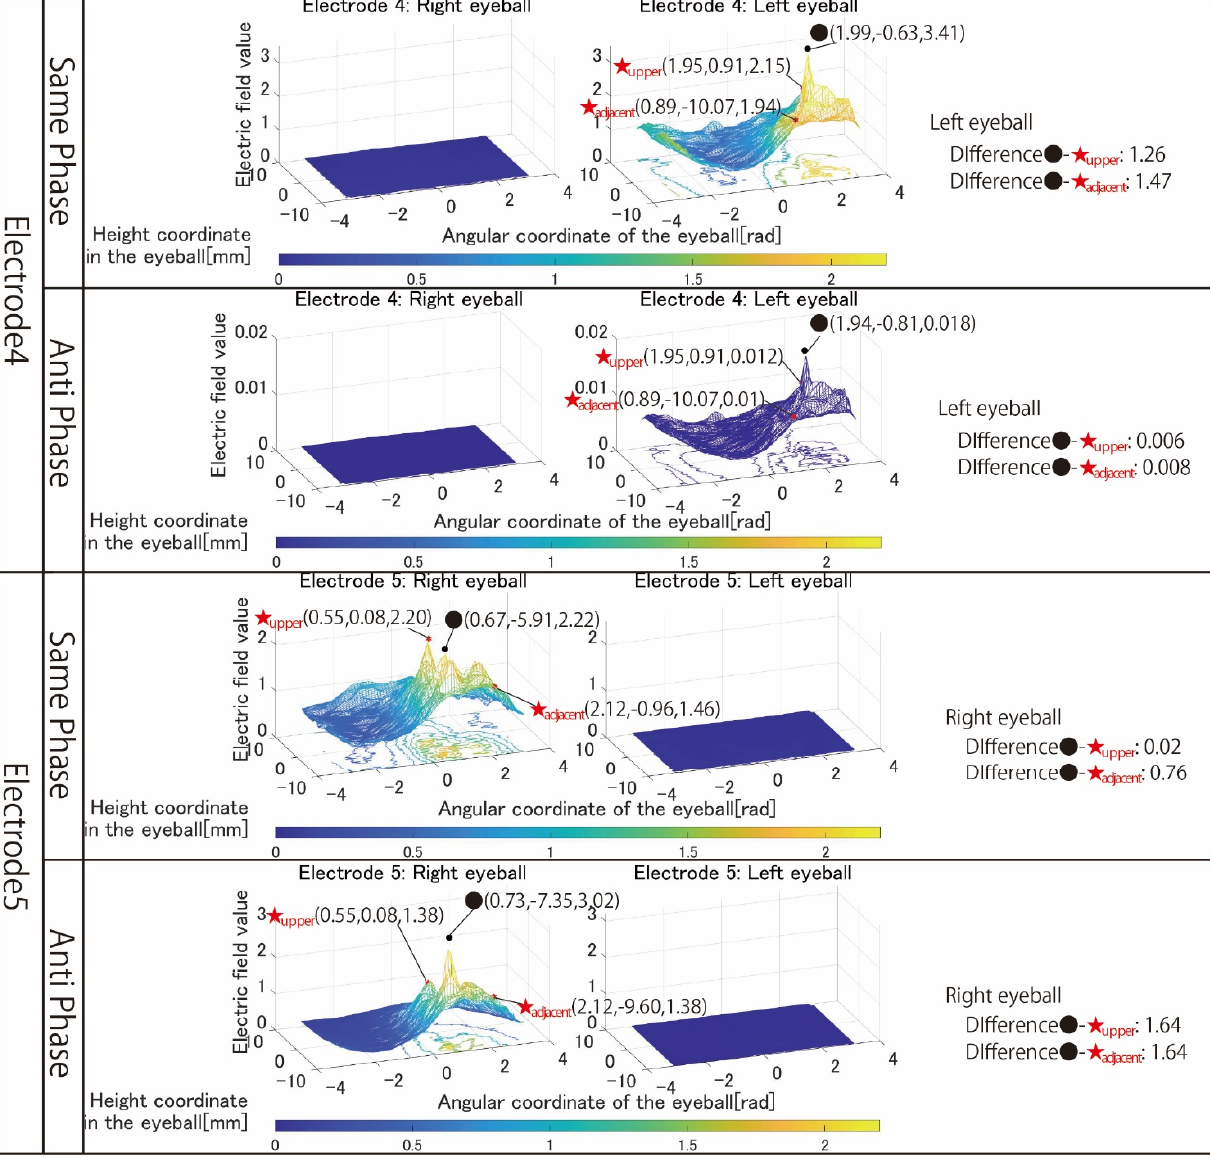
Figure 7. Simulation results with the electrode arrangement to stimulate the temporal and central eyeball.